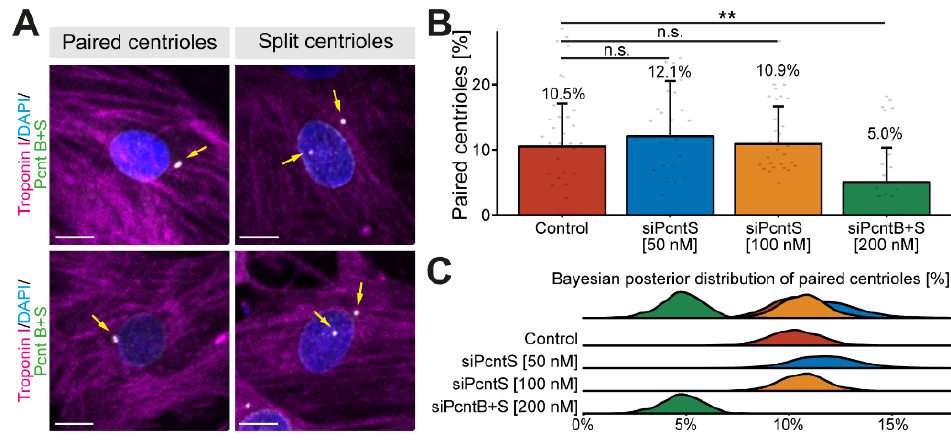
Figure 3. Effect of Pcnt depletion on centriole configuration. ( A ) Representative examples of P3 cardiomyocytes (troponin I) with paired and split centrioles detected by immunofluorescence analysis of Pcnt S and Pcnt B (Pcnt B + S). Nuclei were visualized with DAPI (DNA). ( B ) Quantitative analysis of cardiomyocytes with paired centrioles for control cells (mock-transfected) and upon Pcnt isoform depletion as indicated. ( C ) Bayesian posterior distribution for the results in ( B ). Scale bars: 10 µm. Yellow arrows: centrioles/centrosomes. Data are mean ± SD, n = 3, n.s.: p > 0.05, **: p < 0.01.